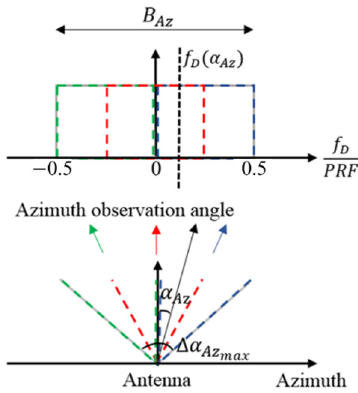
Figure 1. Schematic representation of the SAR-image frequency spectra filtering effect on the azimuth observation angle [30]. Three sublooks with 50% overlap are represented by the green, red, and blue dashed lines (two are independents). A black dashed line illustrates (1), which describes the relationship between the Doppler frequency f D and the azimuth observation angle α Az . PRF is the pulse repetition frequency, and B Az is the azimuth bandwidth at full resolution. Two sublook images 𝑠 (cid:2869) and 𝑠 (cid:2870) with the same 𝛼 (cid:3002)(cid:3053) and ∆𝛼 (cid:3002)(cid:3053) can be acquired by